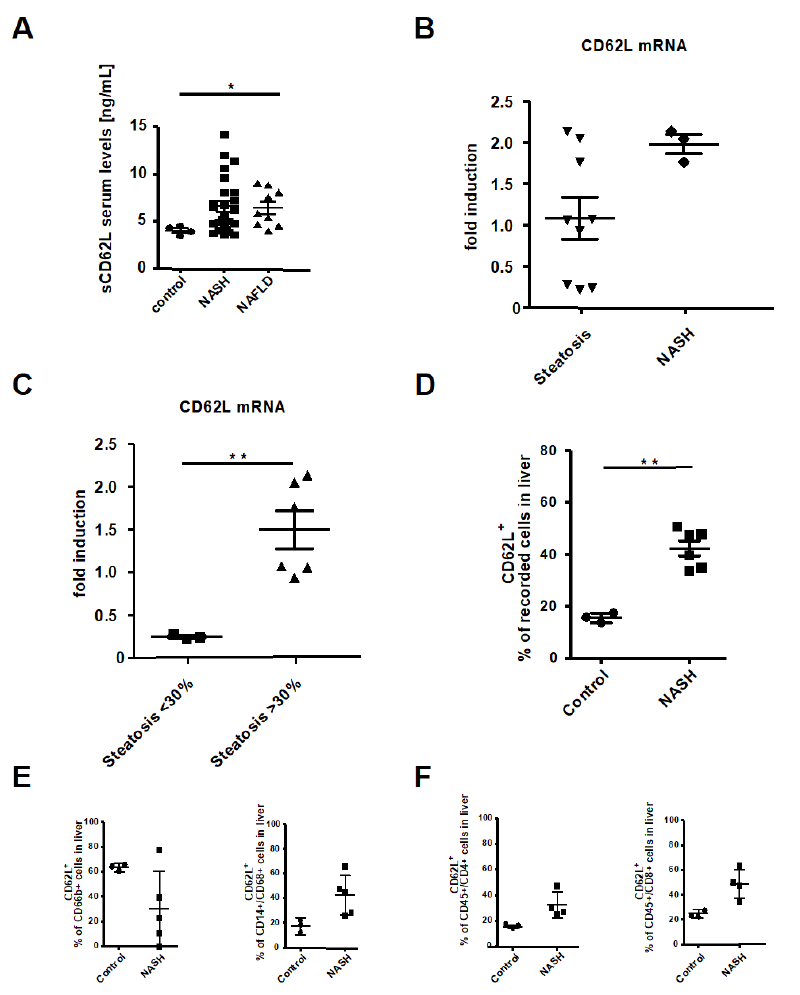
Figure 1. CD62L (L-Selectin) is increased in non-alcoholic steatohepatitis (NASH) patients. ( A ) Serum levels of soluble L-Selectin were measured via ELISA in depicted patient groups (* p < 0.05). ( B ) Liver biopsy samples were analysed for CD62L mRNA expression by RT-qPCR. The values were expressed as fold induction over the mean values obtained for control patient liver biopsies. ( C ) Results from ( B ) were grouped by patients with < 30% and < 30% steatosis. Values were expressed as fold induction over the mean value obtained for control patient samples (** p < 0.01). ( D ) Intrahepatic CD62L + cells were analysed by flow cytometry in depicted patient groups. Cells were gated via, forward scatter/side scatter (FSC/SSC) duplets were excluded, living cells, CD45 + /CD62L + . Depicted is the analysis of the percentage of recorded cells (* p < 0.05, ** p < 0.01). ( E ) Intrahepatic CD62 + /CD66b + neutrophils and CD14 + /CD68 + /CD62L + monocytes were analysed by FACS. Analysis included control patients and patients suffering from NASH. Intrahepatic cells were gated by FSC/SSC, duplets were excluded, living cells, CD45 + , CD66b + , CD62L or CD14 + /CD68 + , CD62L + . Displayed is the percentage of CD62L + cells in liver biopsy samples. ( F ) Intrahepatic CD4 + /CD62L + and CD8 + /CD62L + T cells were analysed by FACS in control and NASH patients. CD4 + /CD62L + and CD8 + /CD62L + T cells were gated by FSC/SSC, duplets were excluded, living cells, CD45 + , CD4 + /CD62L + or CD8 + /CD62L + . Results are displayed as percentage of CD62L + cells (** p < 0.01, *** p < 0.001).